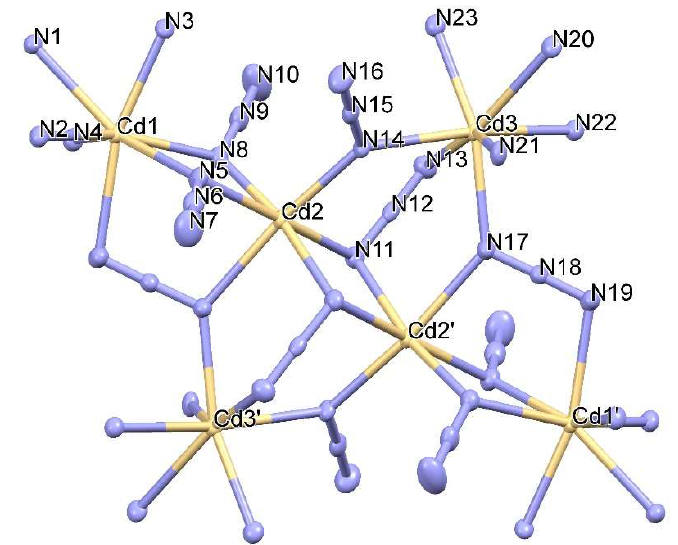
Figure 2. The Cd-N core of [Cd 6 (TPA) 4 (μ 3 -1,1,3-N 3 ) 4 (μ 2 -1,1-N 3 ) 6 ] 2+ cluster unit. Symmetry code (‘): 1 − x, 1 − y, 1 − z. The [Cd 6 (TPA) 4 (μ 1,1,3- N 3 ) 4 (μ 1,1- N 3 ) 6 ] 2+ units co-crystallize with ClO 4− counter anions and